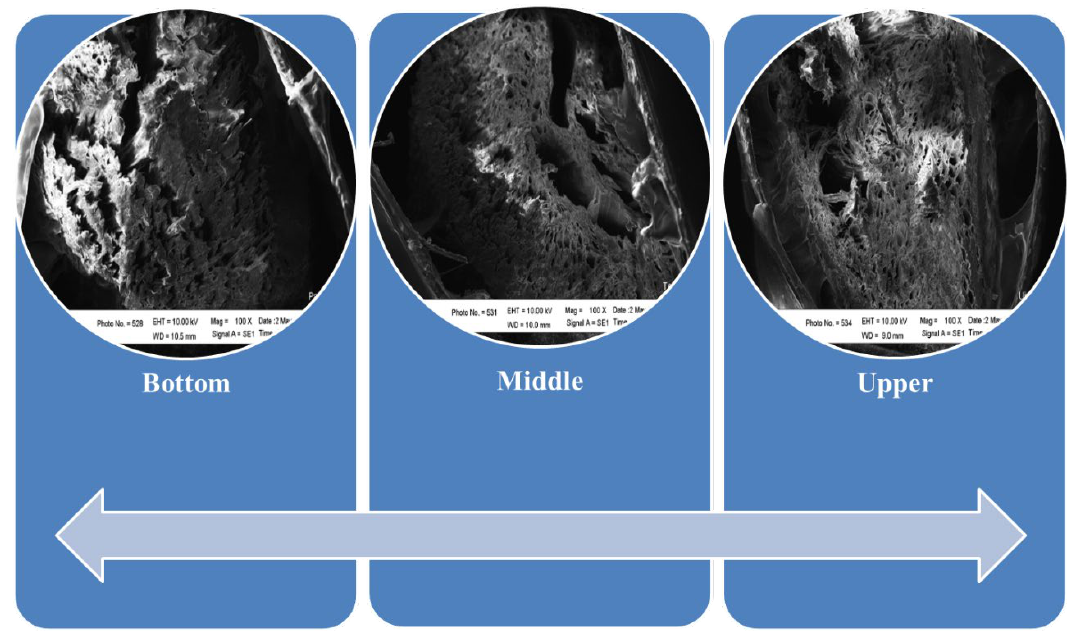
Figure 6. Vascular bundles of OPT showed no differences among the bottom, middle, and upper parts (100× magnifications).